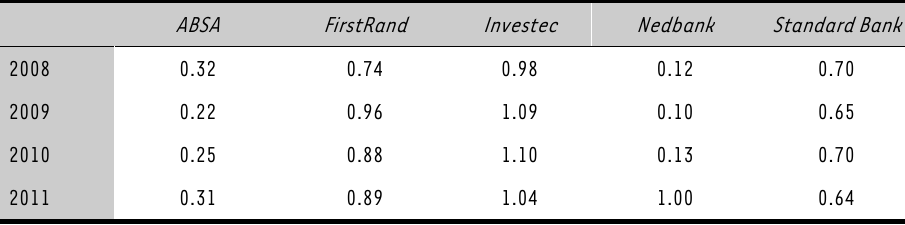
TABLE 13: Yearly current ratio ABSA FirstRand Investec Nedbank Standard Bank